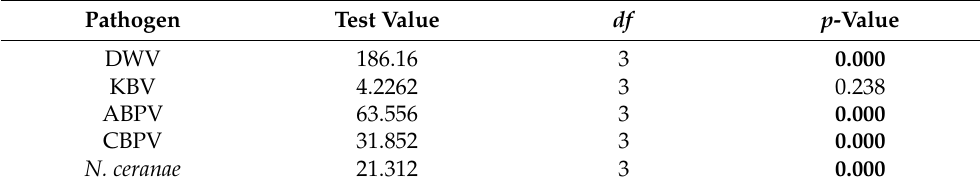
Table 4. Results of Kruskal–Wallis tests of pathogen abundance in the sampling months. Significant values are shown in bold.